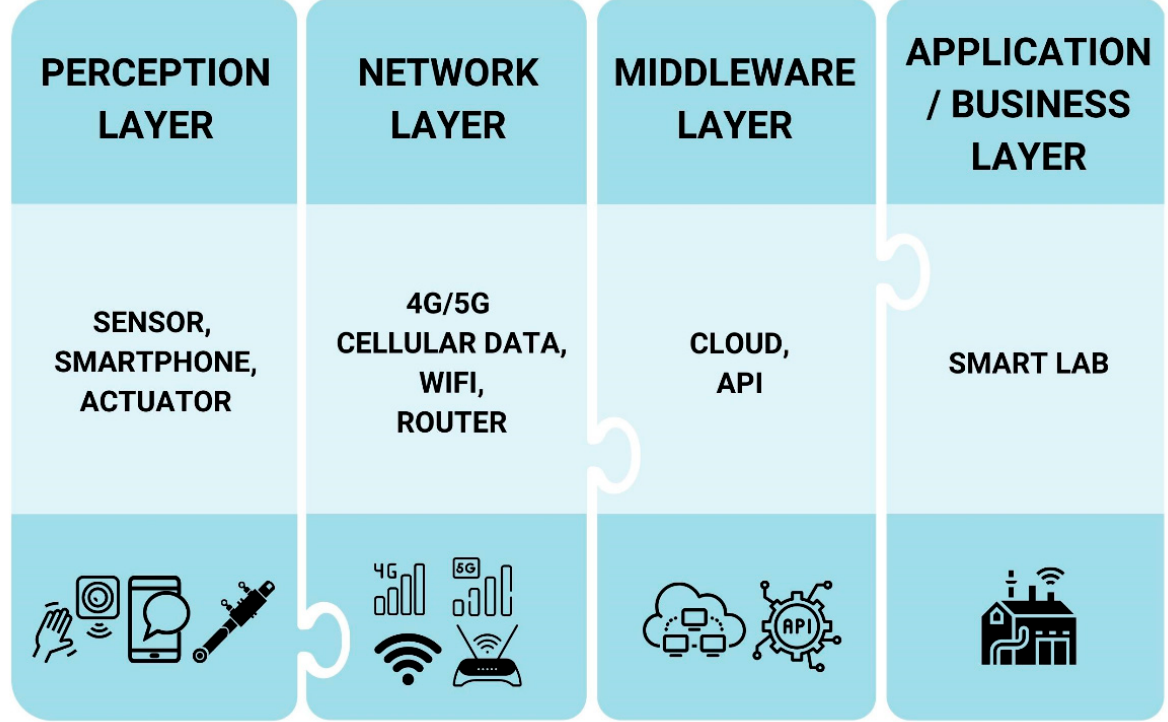
Figure 1. The architecture of IoT in clinical laboratories. Adapted from Ashton [31].